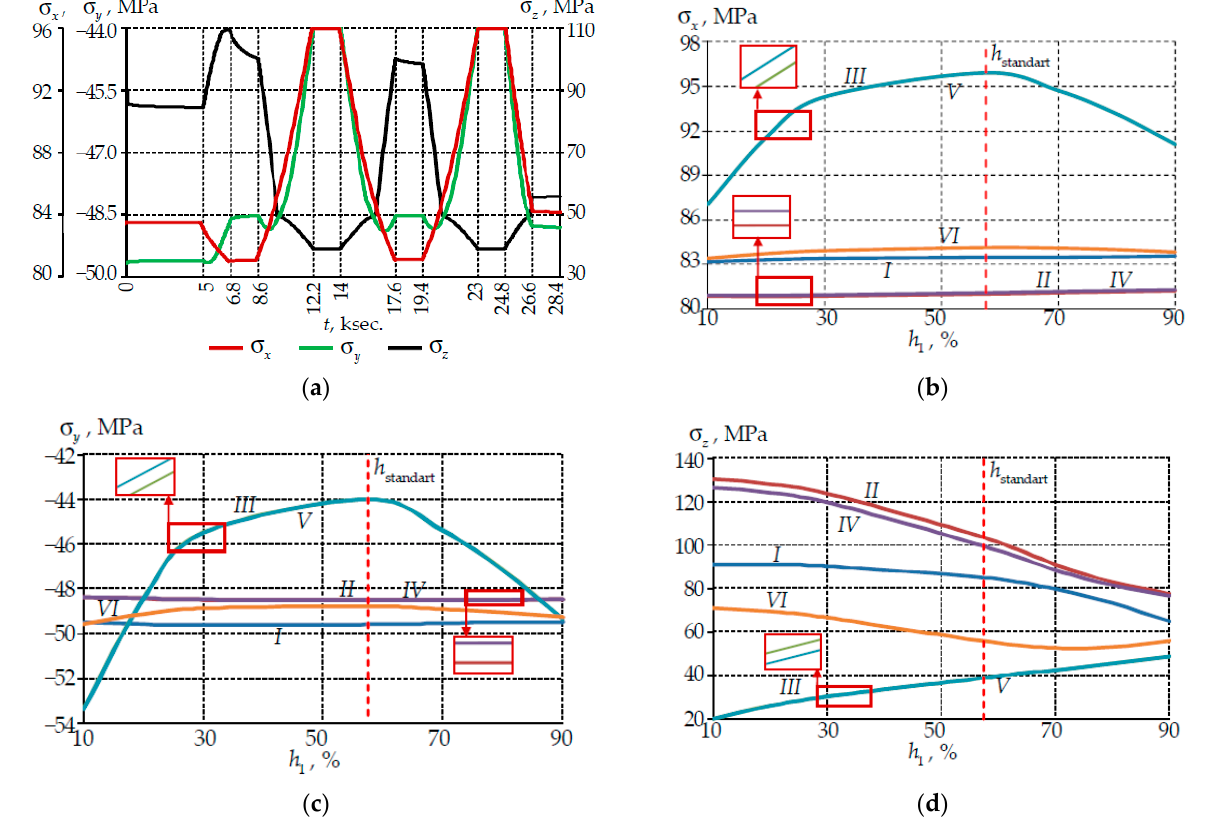
Figure 7. Stresses in the fiber light-conducting core center: ( a ) evolution of stresses within the ther- σ σ on the PC thickness; ( c ) dependence of mal cycle at standard ratio PC; ( b ) dependence of cycle at standard ratio PC; ( b ) dependence of σ x on the PC thickness; ( c ) dependence of σ y on the PC y x σ on the PC thickness; I–VI are numbers of holding zone on the PC thickness; ( d ) dependence of thickness; ( d ) dependence of σ z on the PC thickness; I–VI are numbers of holding zone at constant z temperature; I is 23 ◦ C; II is 60 ◦ C; III is − 60 ◦ C; IV is 60 ◦ C; V is − 60 ◦ C; VI is 23 ◦ C. at constant temperature; I is 23 °C; II is 60 °C; III is − 60 °C; IV is 60 °C; V is − 60 °C; VI is 23 °C.